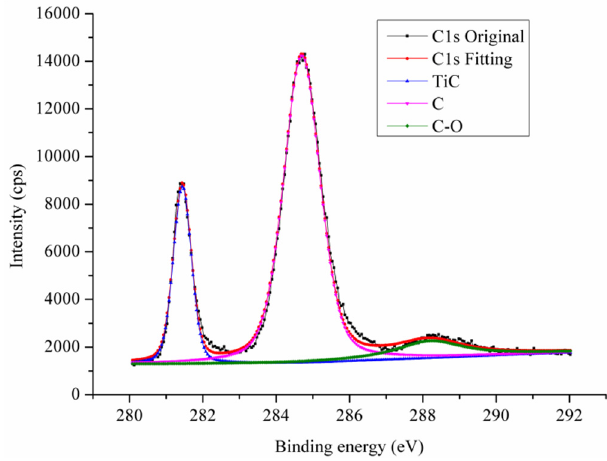
Figure 6. Electronic spectra of C1s characteristic peak on corrosion interface of titanium alloy in argon.